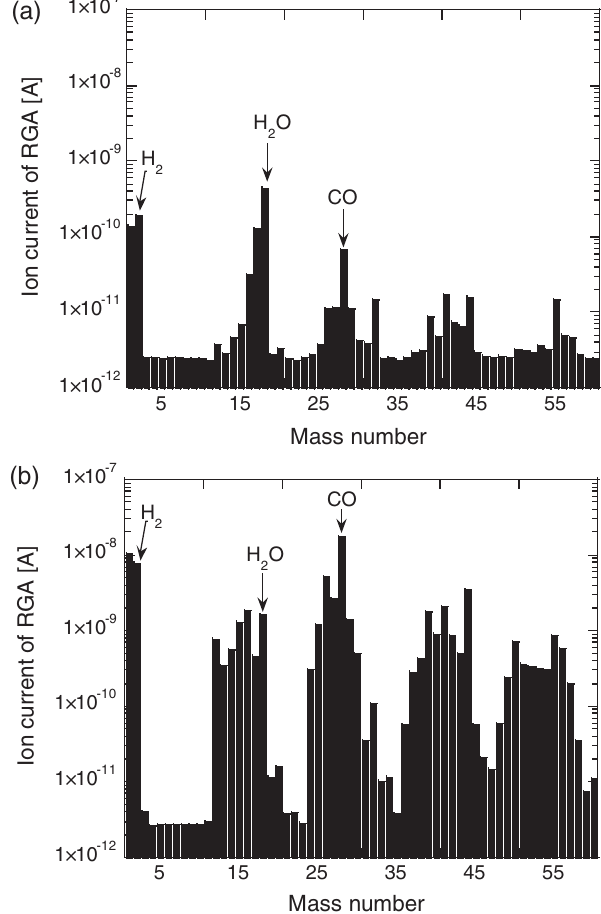
FIG. 6. Example of residual gas spectra in the beam line (a) without and (b) with beam measured by the RGA in the second arc section. Each spectrum corresponds to points α and β in Fig. 5,